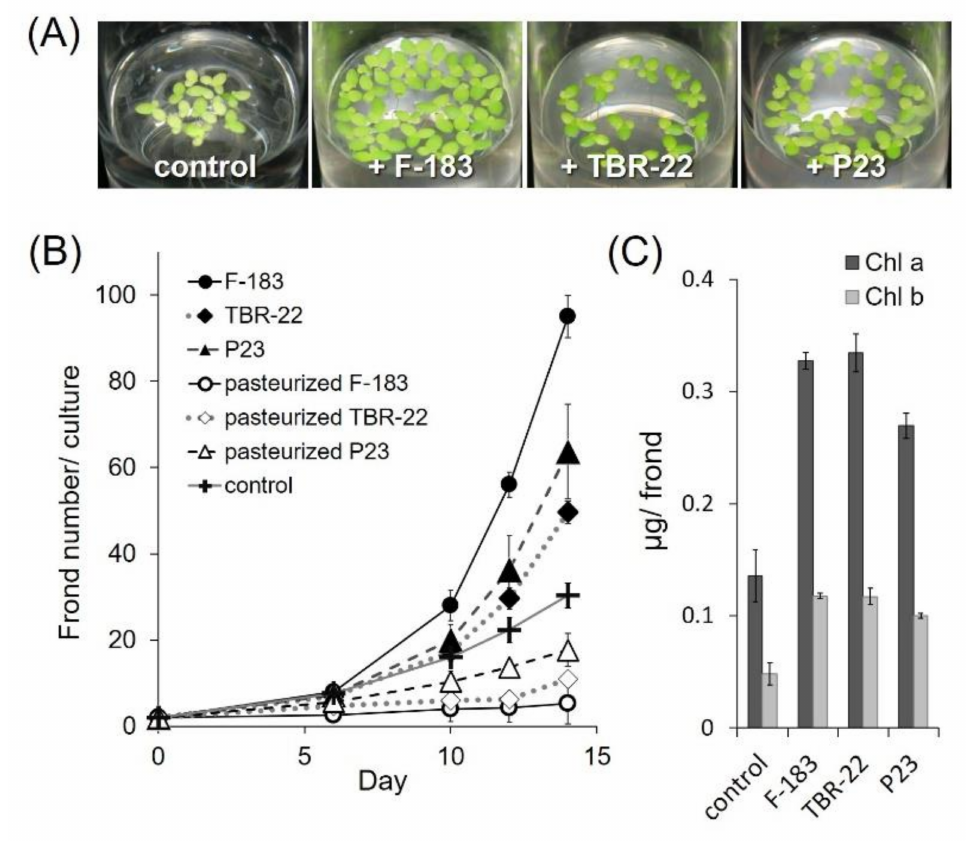
Figure 2. ( A ) Growth of L. aequinoctialis co-cultured for 14 days without bacteria (control), with the F-183 strain, the TBR-22 strain, or the P23 strain. ( B ) Growth of L. aequinoctialis with active and inactive (pasteurized) bacterial cells. ( C ) Chlorophyll a and chlorophyll b contents of L. aequinoctialis after co-cultivation with bacterial strains. Values are expressed as means of three independent experiments. Bars,